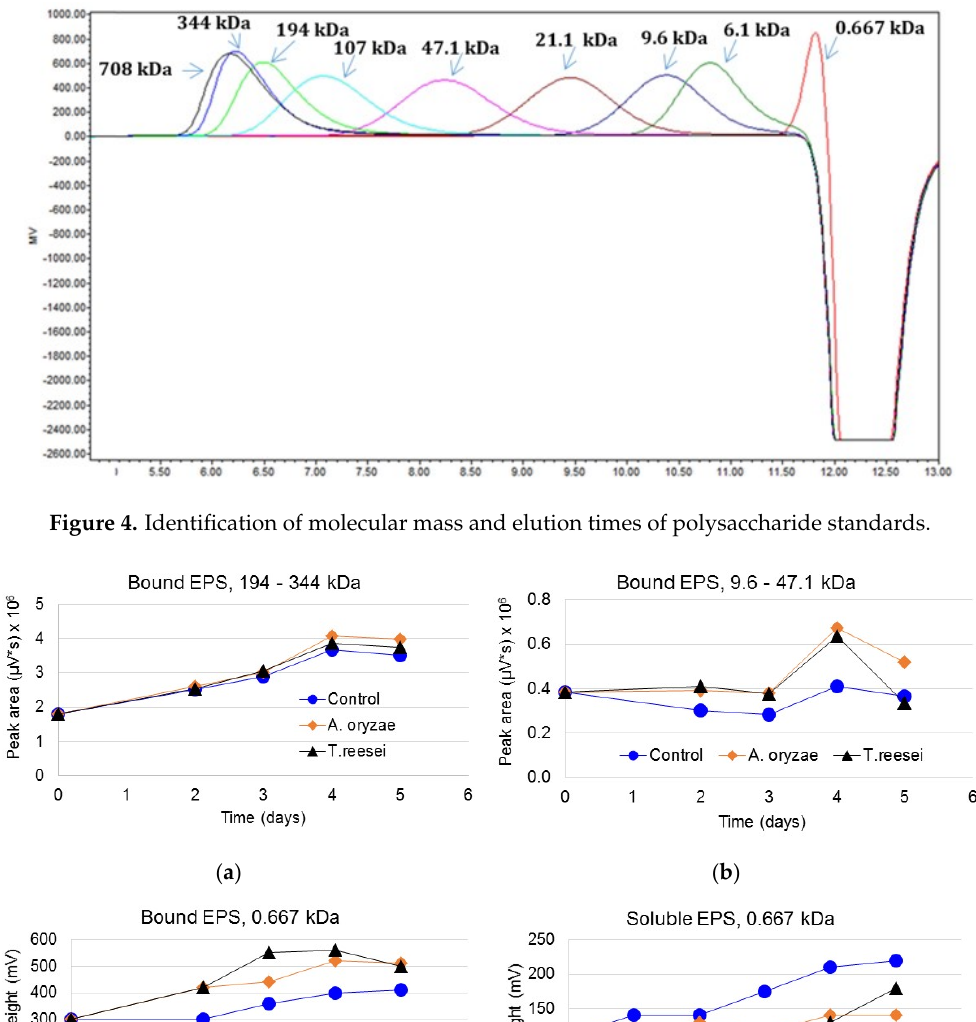
Water 2016 , 8 , 531